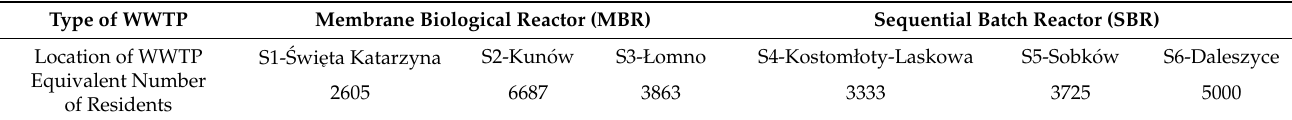
Table 2. Characteristics of WWTPs.